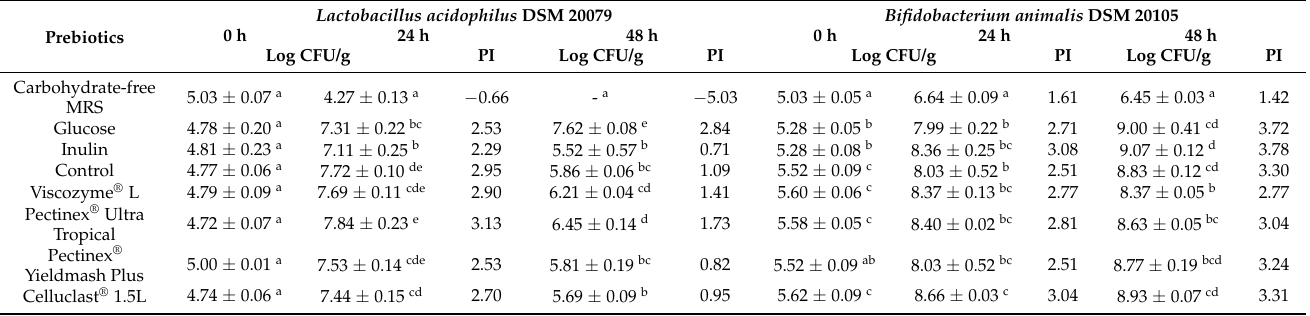
Table 3. Growth of probiotics in medium supplemented with different carbohydrate